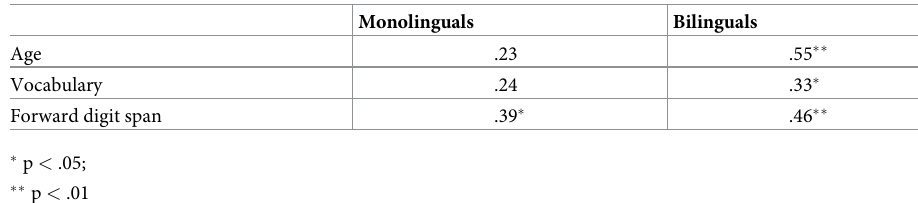
Table 4. Correlations between post-switch game 4 and age, vocabulary, and forward digit